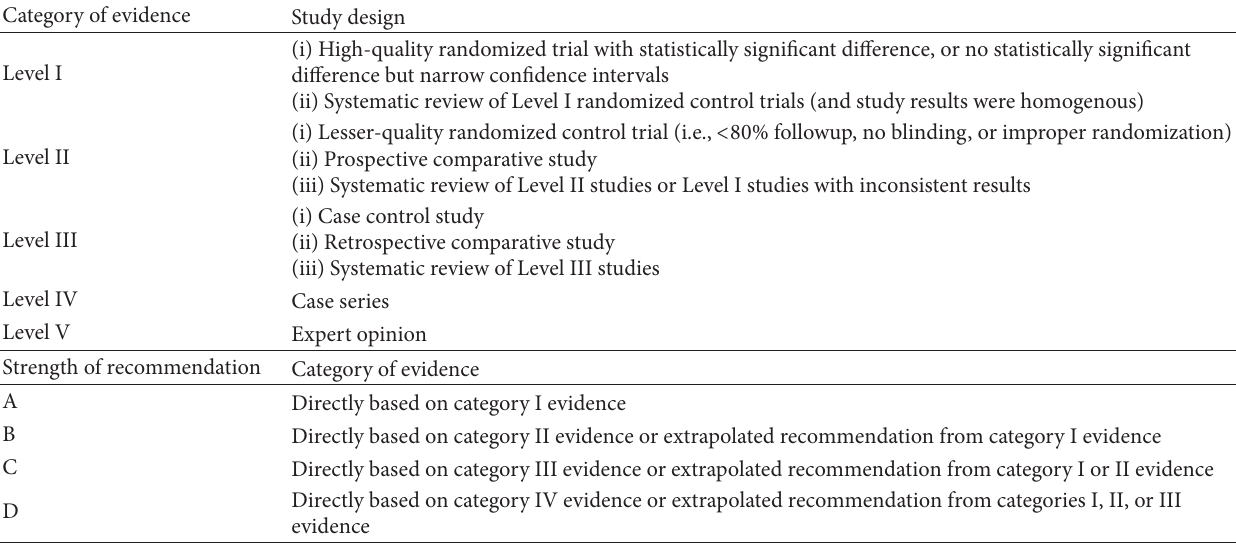
Table 1: Levels of evidence (reproduced and referenced according to [64,